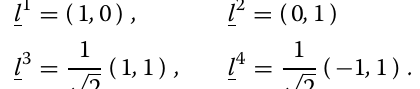
3 (bottom left). Initial conditions for the geometry with 32 grains are generated by the same procedure. In all simulations, the dislocation densities have a uniform initial value of ρ α = 2 · 10 11 m − 2